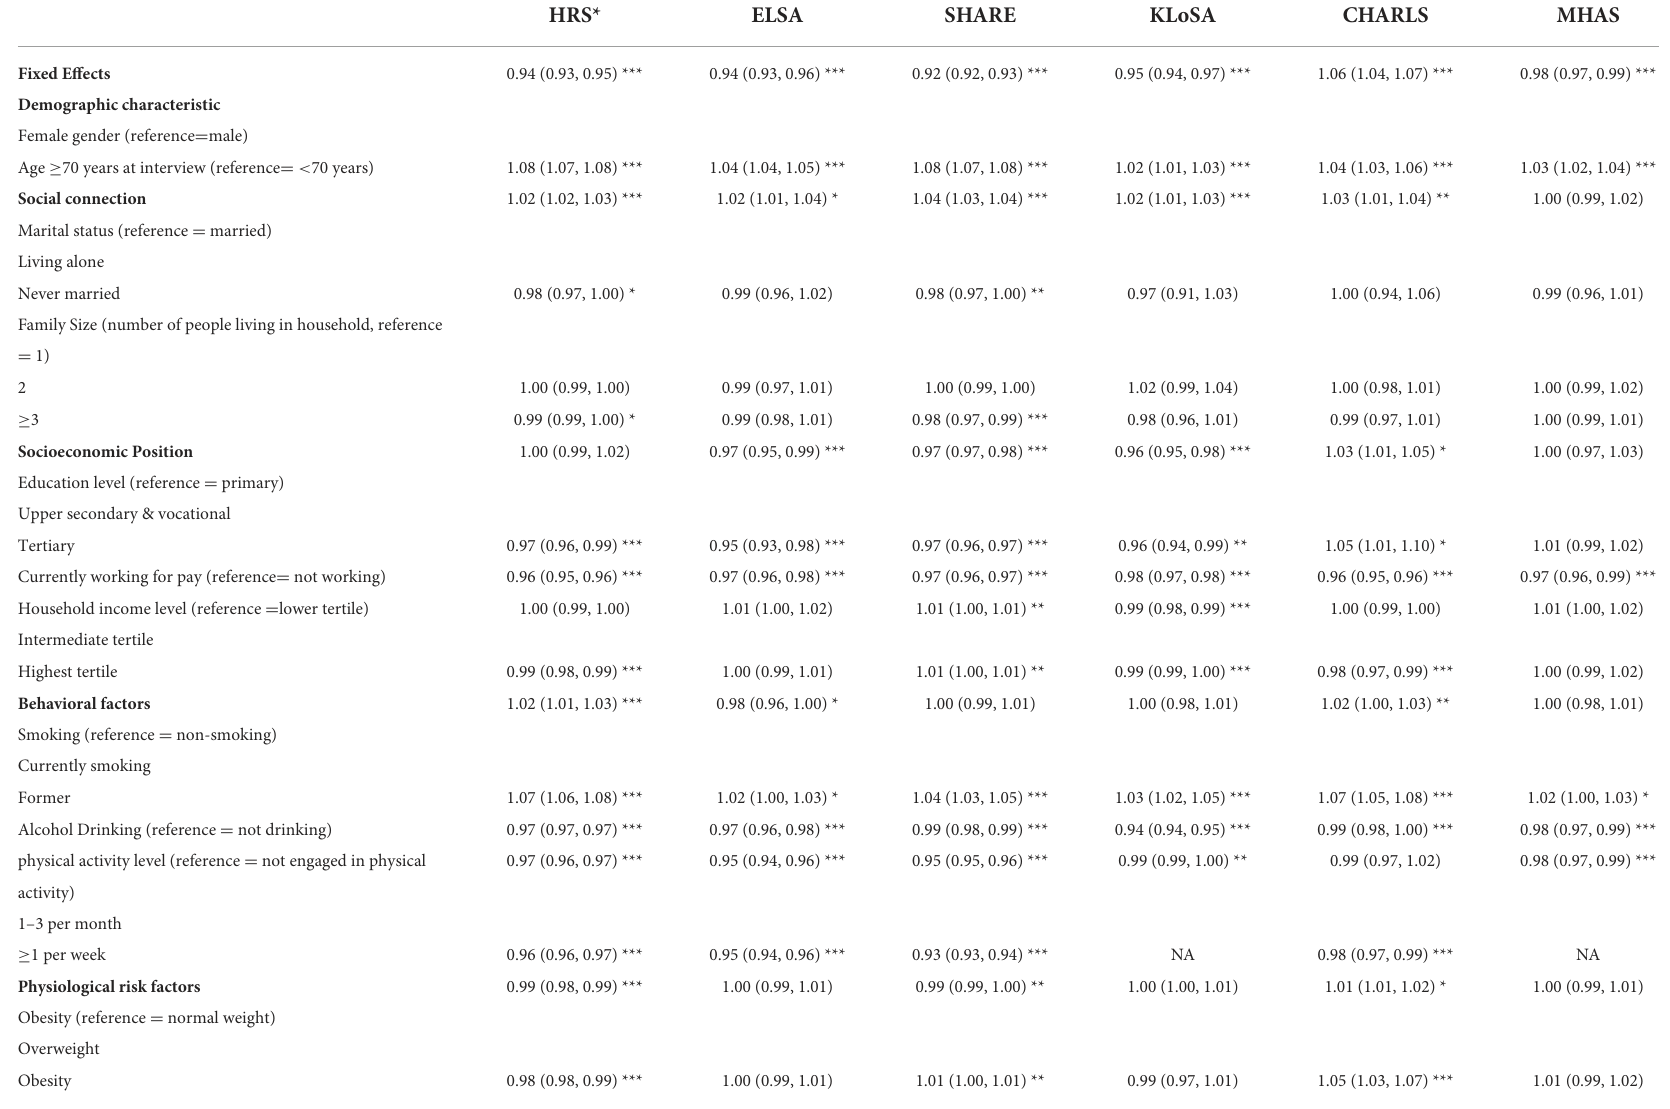
TABLE 2 Factors associated with prevalence of cardiovascular disease by cohort